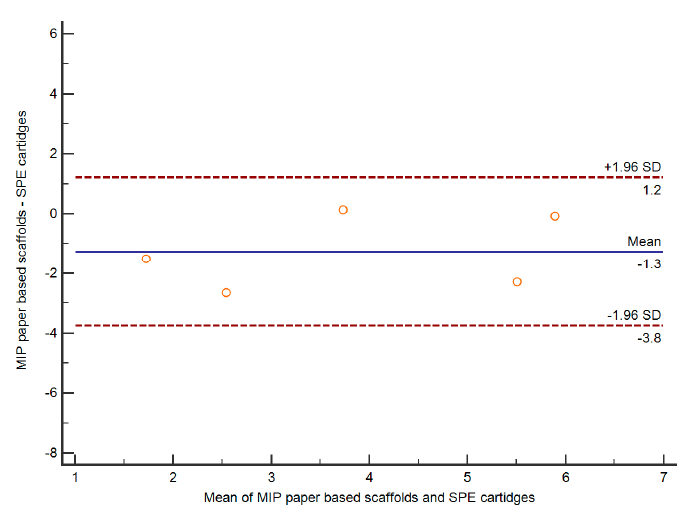
Figure 9. Comparison of results obtained from commercial solid-phase extraction (SPE) cartridges and proposed MIP scaffold.